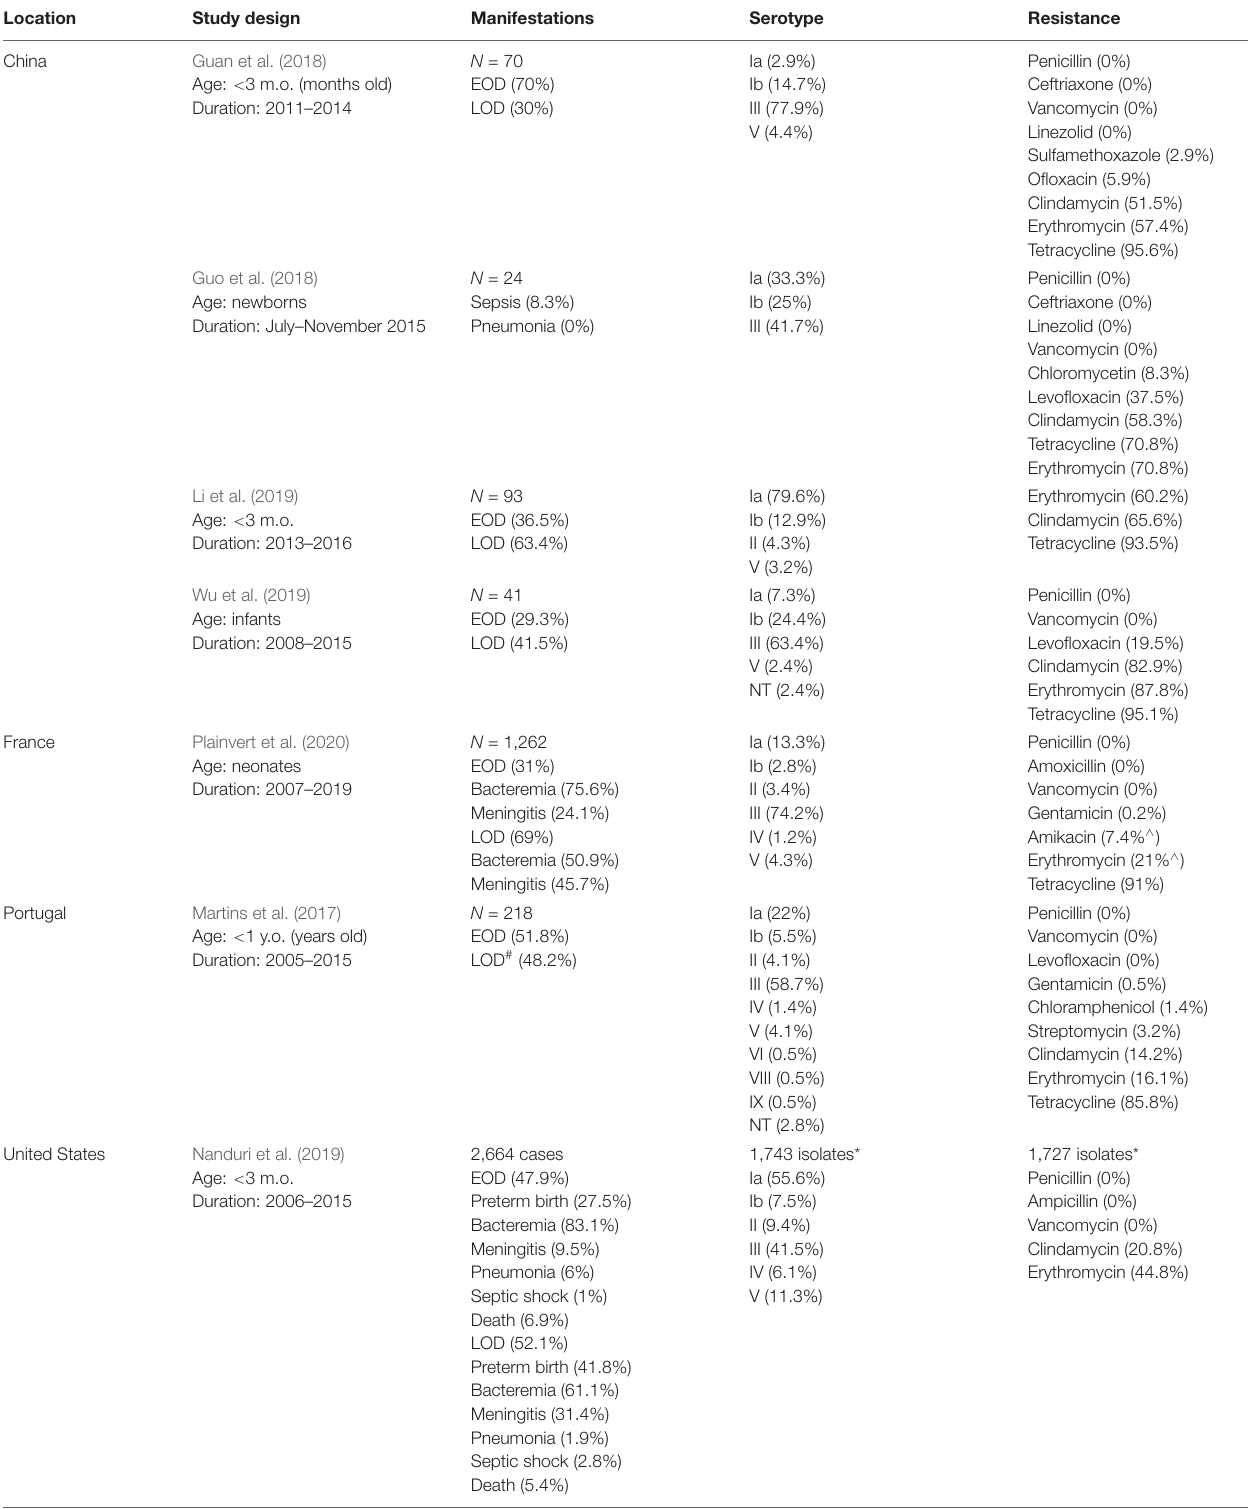
TABLE 1 | Summary of recent studies on antibiotic resistance in neonatal GBS isolates.